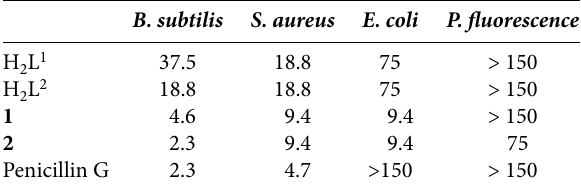
Table 4. Antimicrobial results with MIC ( μ g mL –1